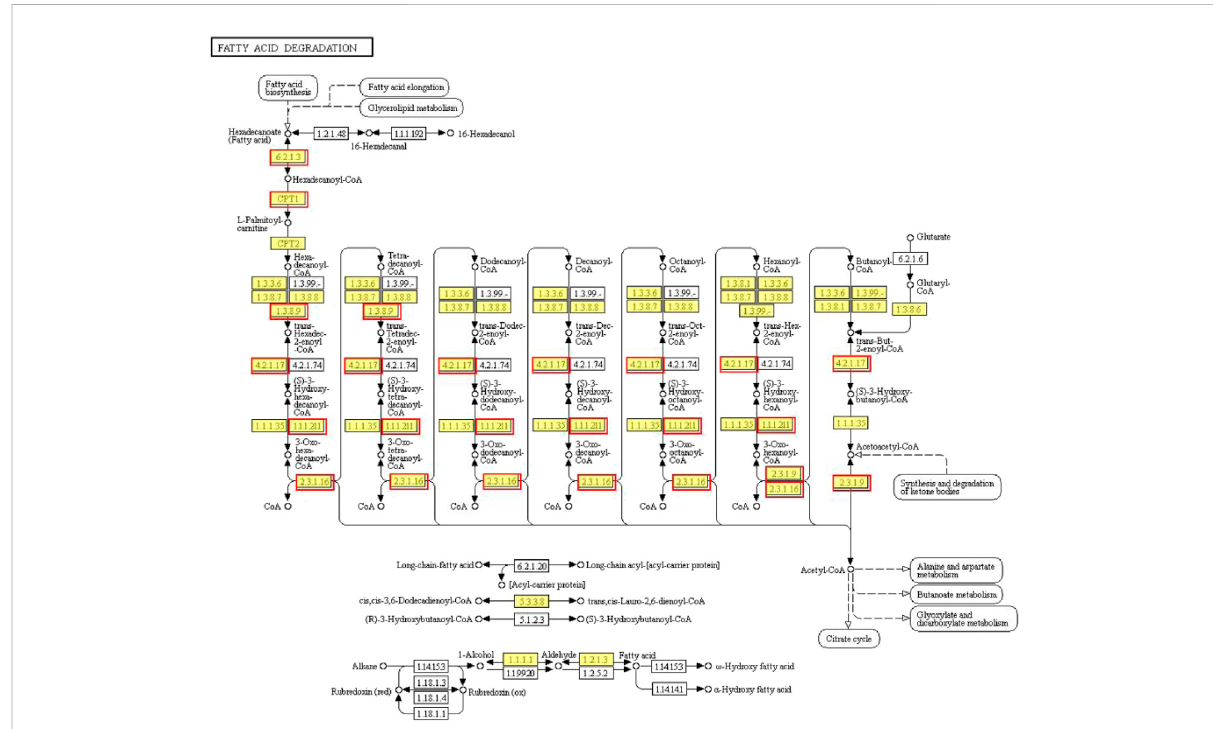
FIGURE 4 Fatty acid degradation pathway identi fi ed in the upregulated genes. The red border represents upregulated genes.